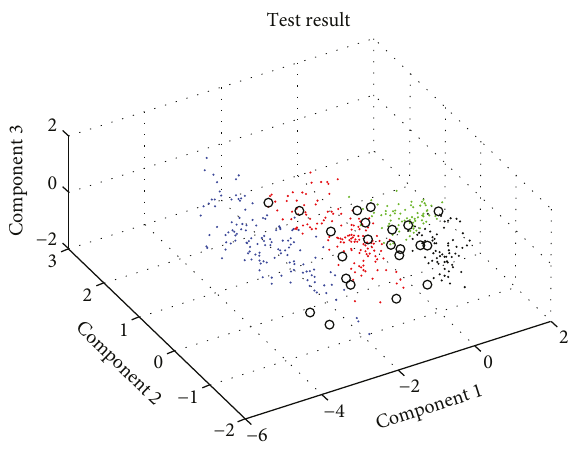
Blue: downhill/hard Red: uphill/hard Green: hard/flat Black: soft/flat Figure 13: The four ground features are described by the fi rst two principal components.